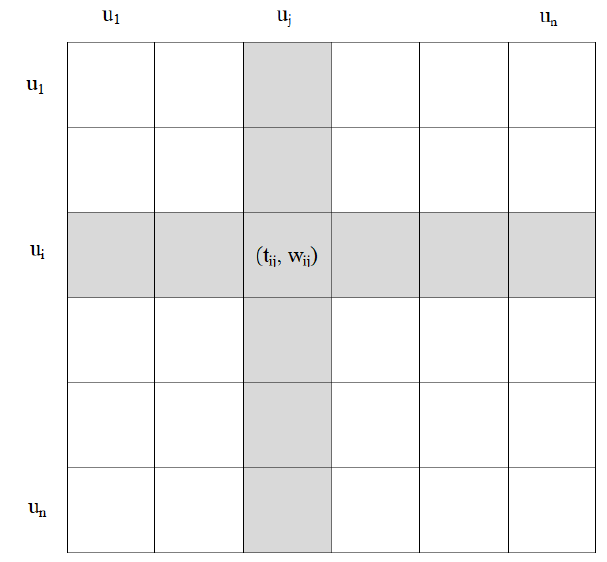
Figure 2. Adjacency-matrix representation of the directed graph of users’ social trust